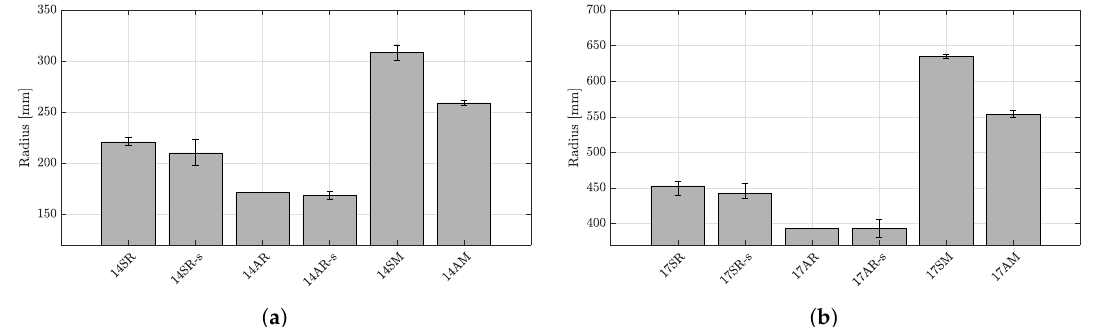
Figure 13. Difference in specimen radius due to variations in the cure cycle, tool material and manufacturing setup. ( a ) Specimens with layup ID14; ( b ) Specimens with layup